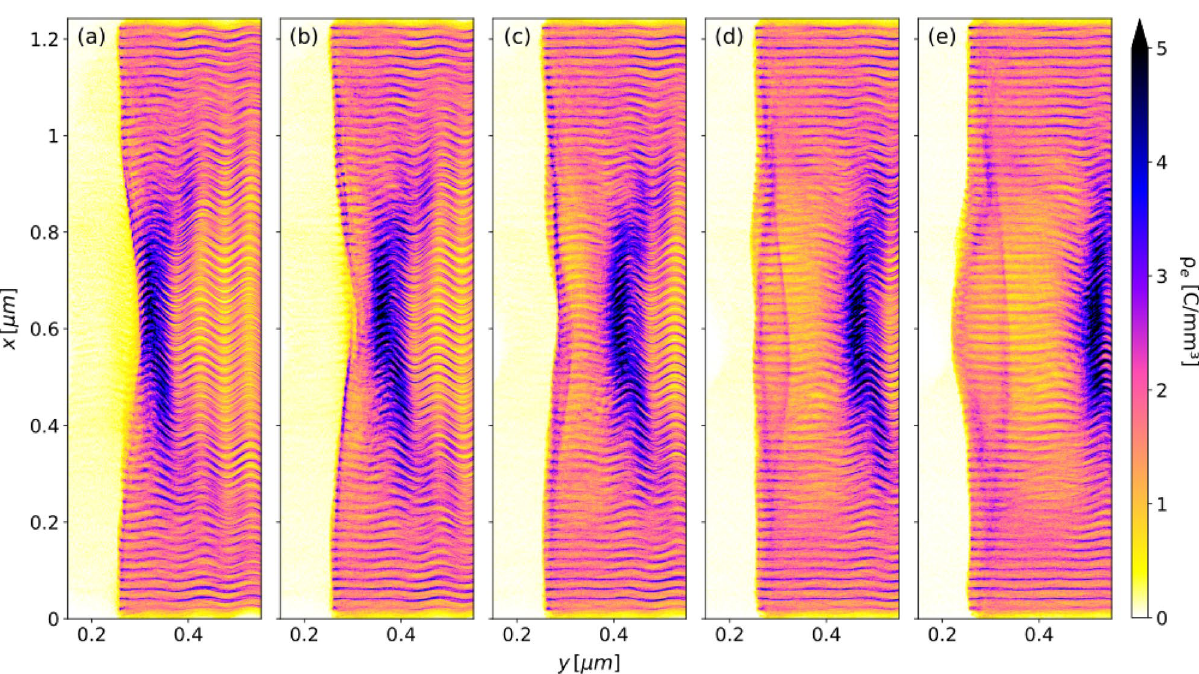
Figure 2. The catapult injection mechanism, shown as electron charge density at: ( a ) t / T = 10.5, ( b ) t / T = 11, ( c ) t / T = 11.5, ( d ) t / T = 12 and ( e ) t / T =